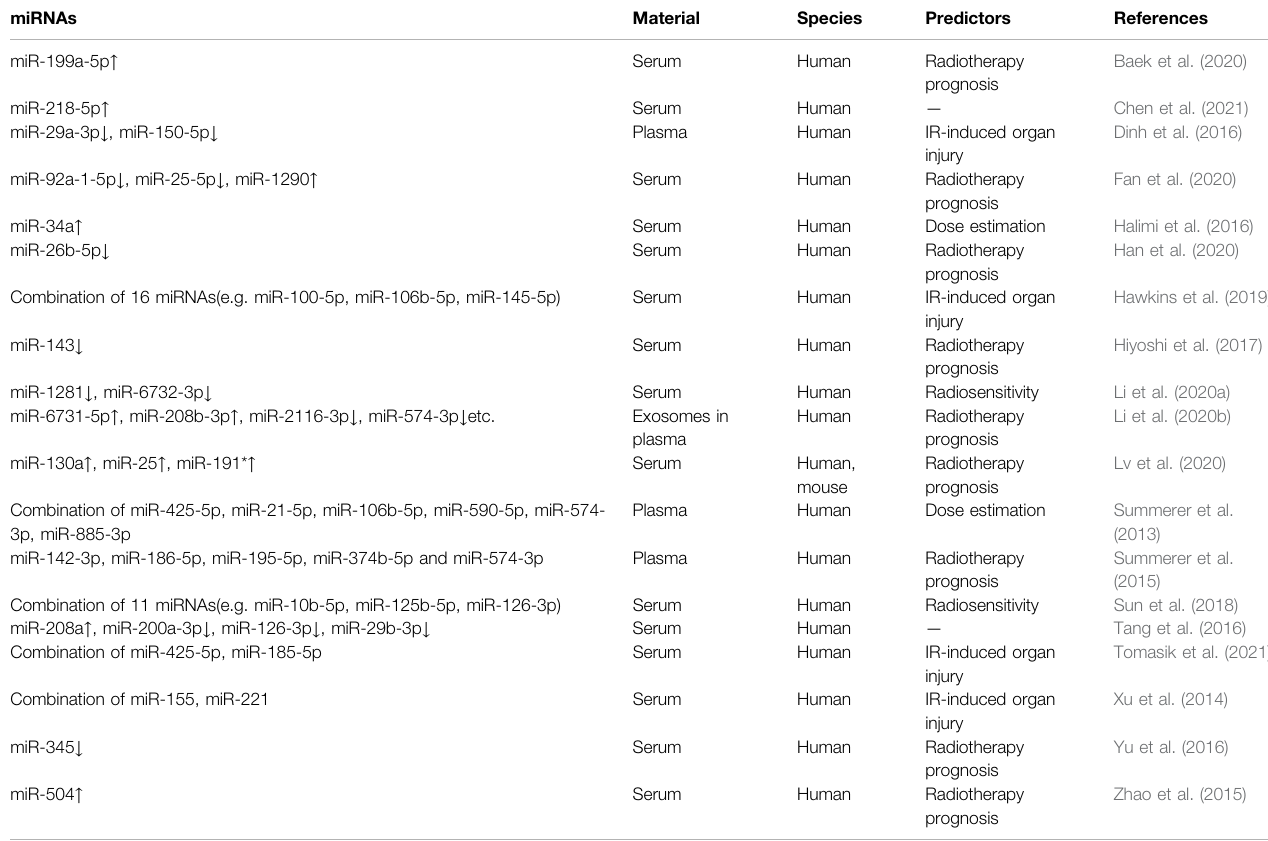
TABLE 1 | Serum or plasma miRNAs as IR biomarkers in human samples. miRNAs